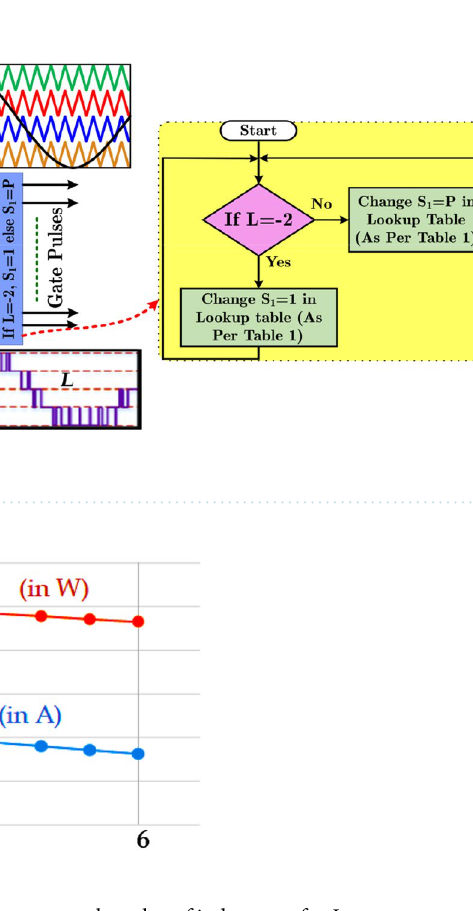
Figure 5. The inductor current ripple and output power vs the value of inductance for L in